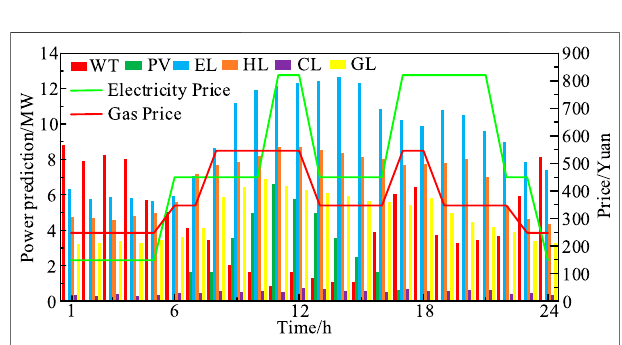
FIGURE 2 | Output of PV and WT, cure of load demand, and price of electricity and natural gas.